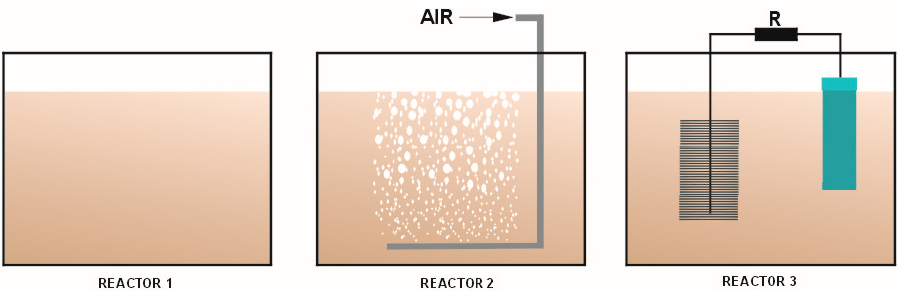
Figure 16. The three types of reactors used in the measurement of wastewater parameters during wastewater treatment: one excluding aeration (Reactor 1—R1), one with aeration (Reactor 2—R2), and as an MFC (Reactor 3—R3).